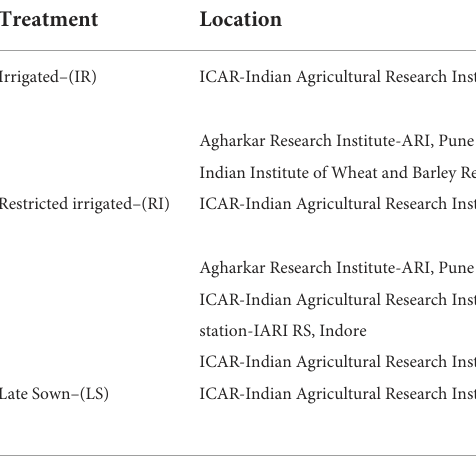
TABLE 1 Details of sowing conditions, locations and year of experiment along with